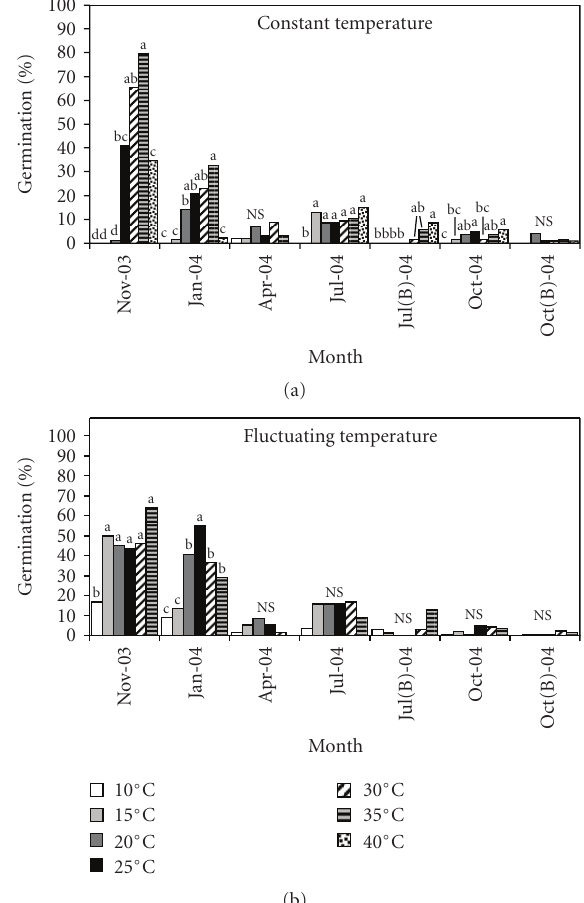
Figure 2: S enna obtusifolia percentage germination in response to constant and fluctuating ( ± 7 . 5 ◦ C) temperatures with after-ripening following maturation in late October 2003. One half of the S. obtusifolia seeds was buried in soil 10 cm deep in Spring 2004; therefore, Summer and Fall evaluations included seeds from the soil surface and buried (B) ones. The fluctuating temperature experiment did not include a mean temperature of 40 ◦ C. Means with di ff erent lowercase letters within a month, thermal amplitude (constant or fluctuating), and burial depth are significantly di ff erent at α = 0 .